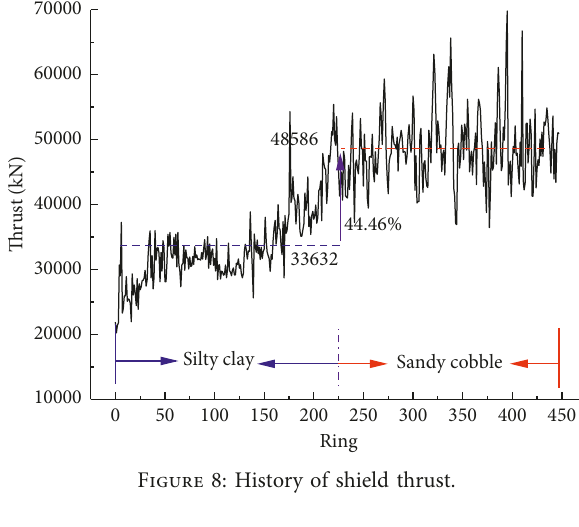
Figure 8: History of shield thrust.